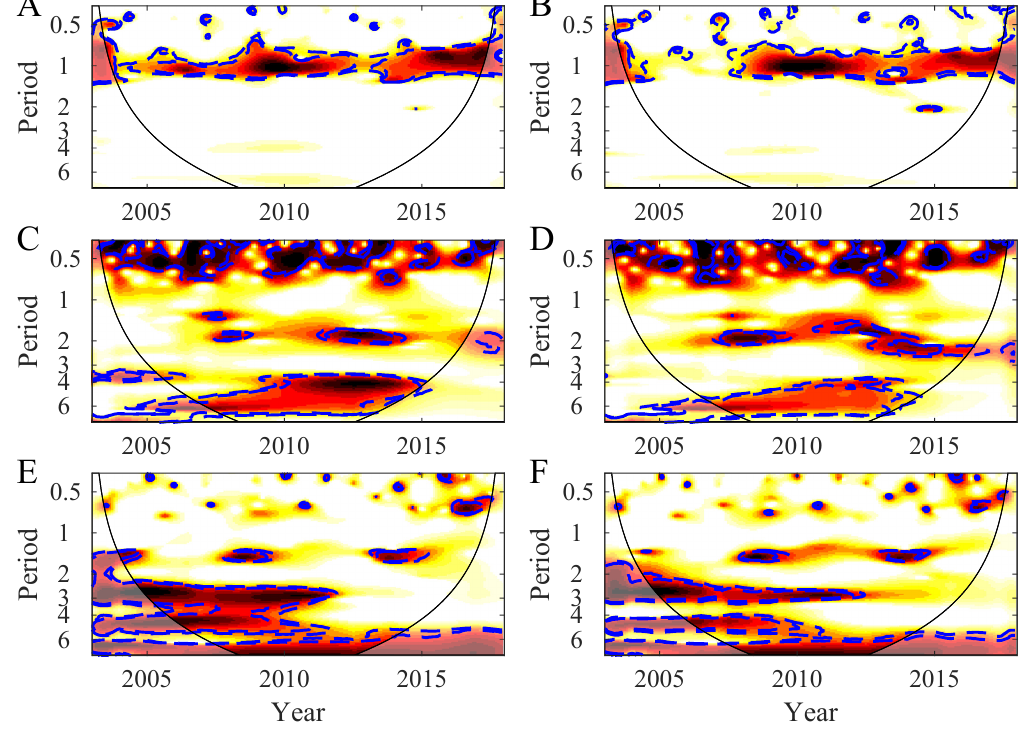
Figure 5. Partial Wavelet Coherences as defined in Figure 4 but for